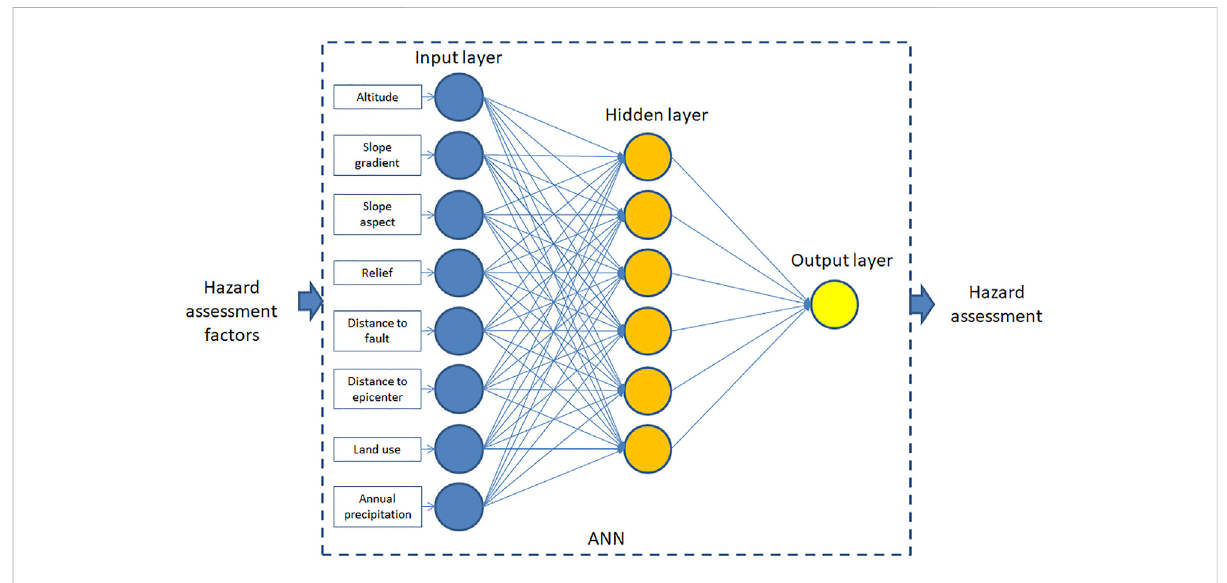
FIGURE 2 Arti fi cial neural networks and landslide hazards